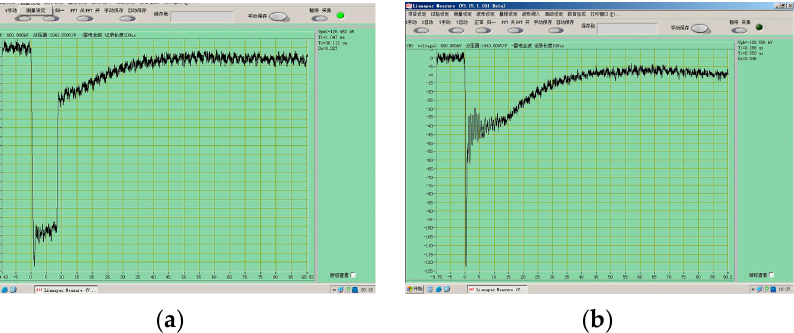
Figure 22. Test process. ( a ) Test sample installation; ( b ) Rock sample; ( c ) Test sample after experi- ment.